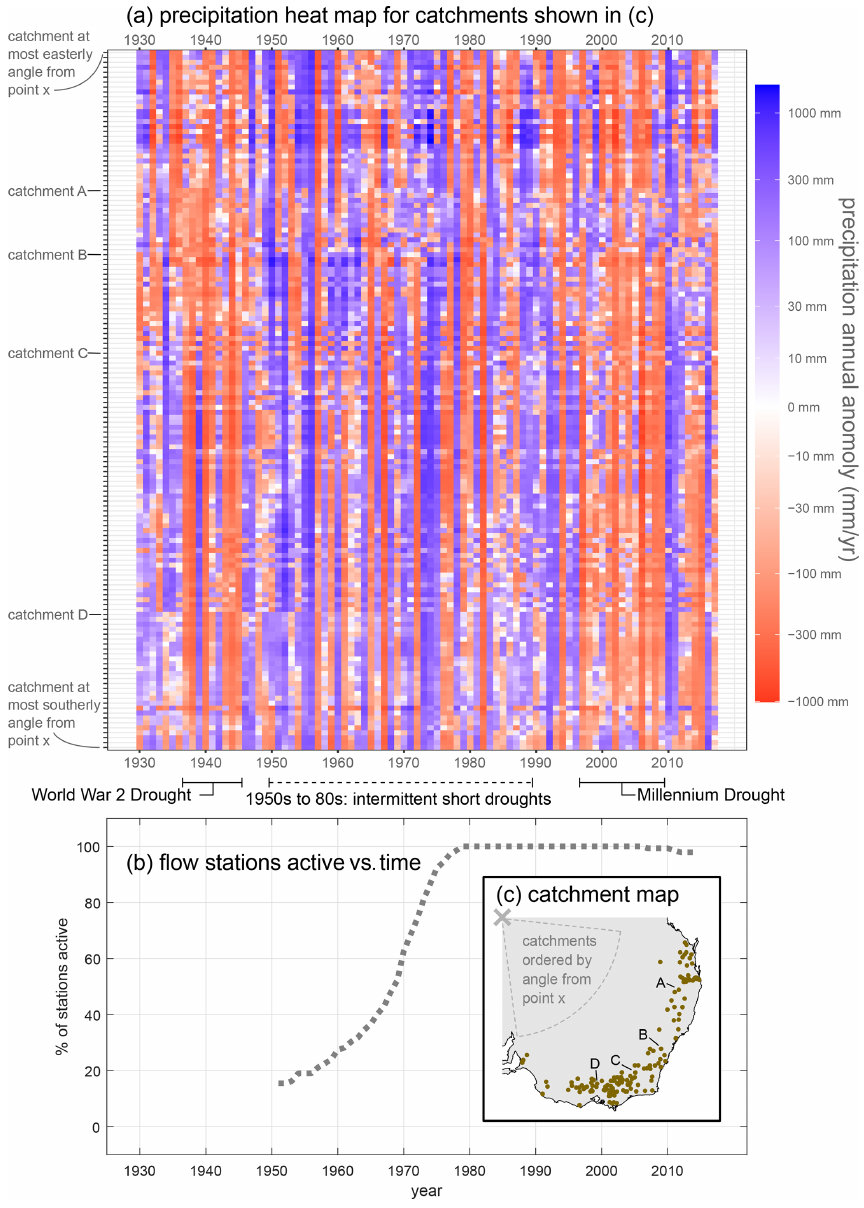
Figure 6. (a, c) Visualisation of the longer duration of the Millennium Drought and World War II Drought, compared to other droughts in the 1950s–1980s, by showing anomalies in annual precipitation. (b) Flow gauging coverage through time. Precipitation and flow data are sourced from Fowler et al.